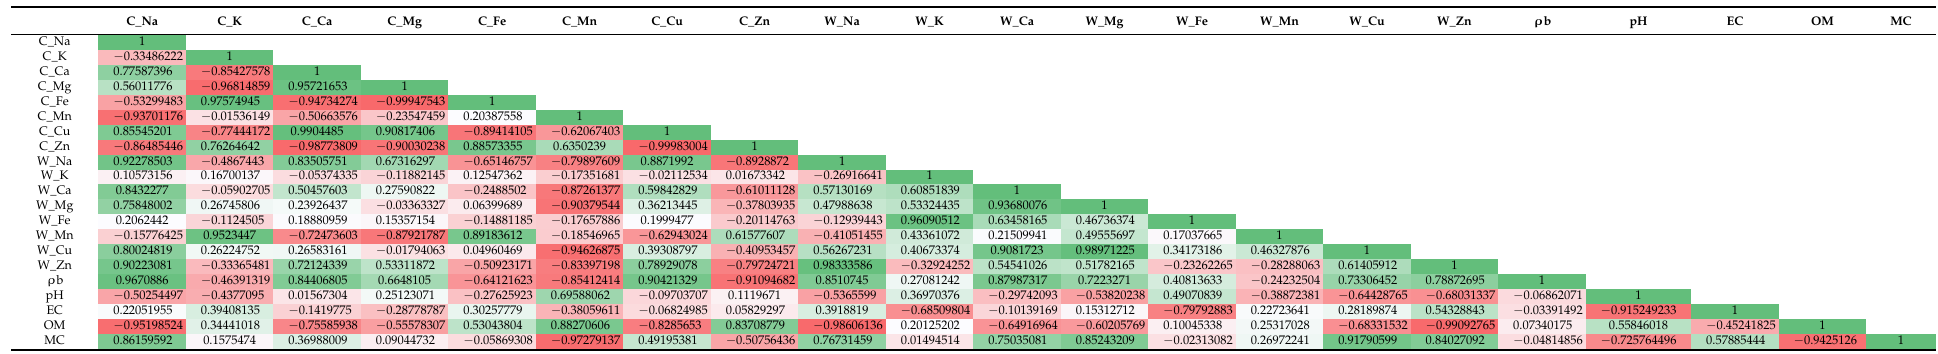
Table A2. Correlation coefficients between elemental composition nutrient content, water extractable nutrient content and physical and chemical properties of